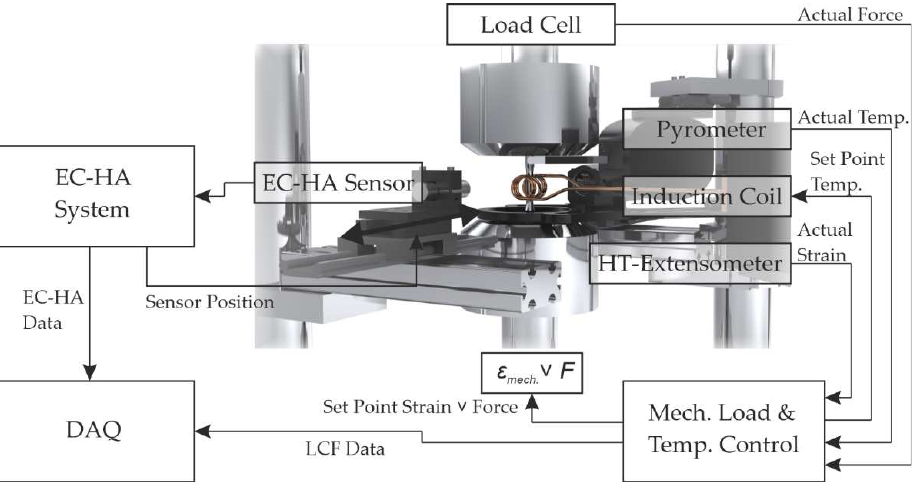
Figure 1. Schematic illustration of the LCF test rig and the integrated non-destructive EC-HA testing system.